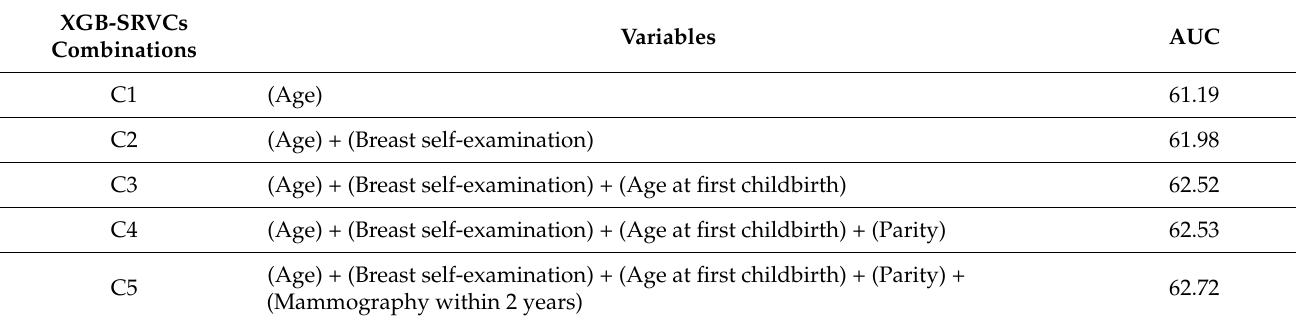
Table 4. Lasso result with